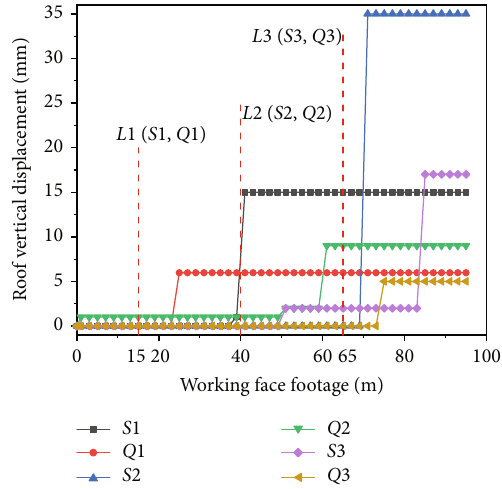
Figure 14: Separation curve of roadway roof.